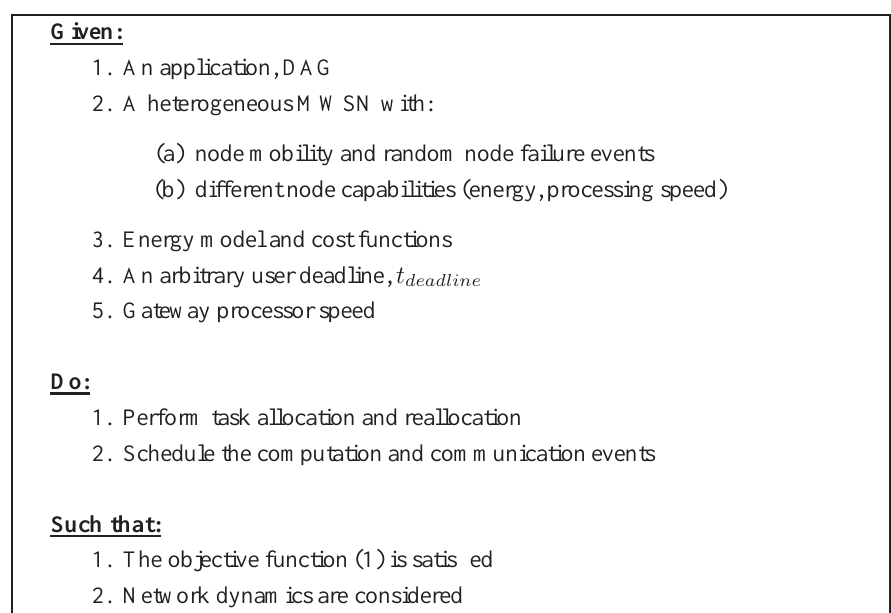
Figure 1. Design